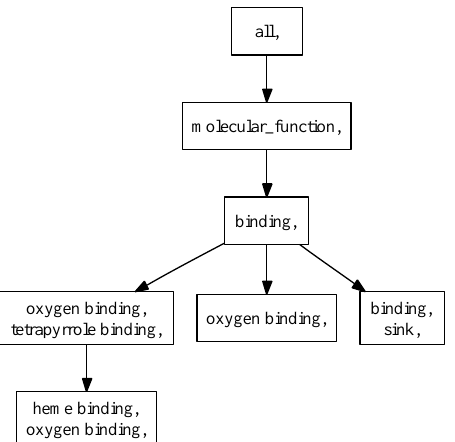
Figure 2: An example of a GO tree representing the ”Globin-like” superfamily. A combination of functions can be observed in some domains, as well as a ‘sink’ leaf introduced for those domains that were only annotated as binding.